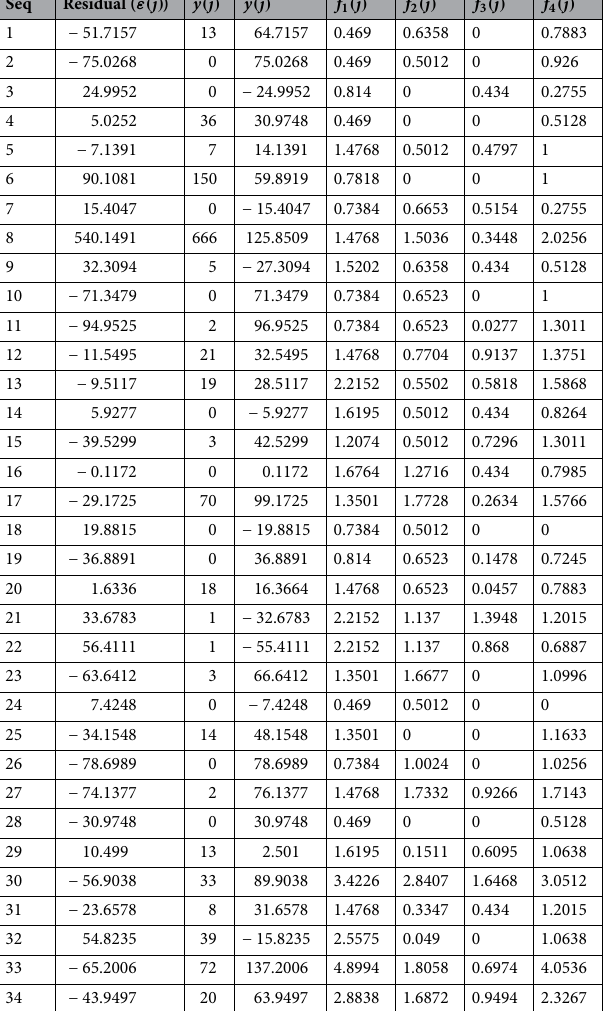
Table 5. Fitting value of each variable in 34 groups of test data.